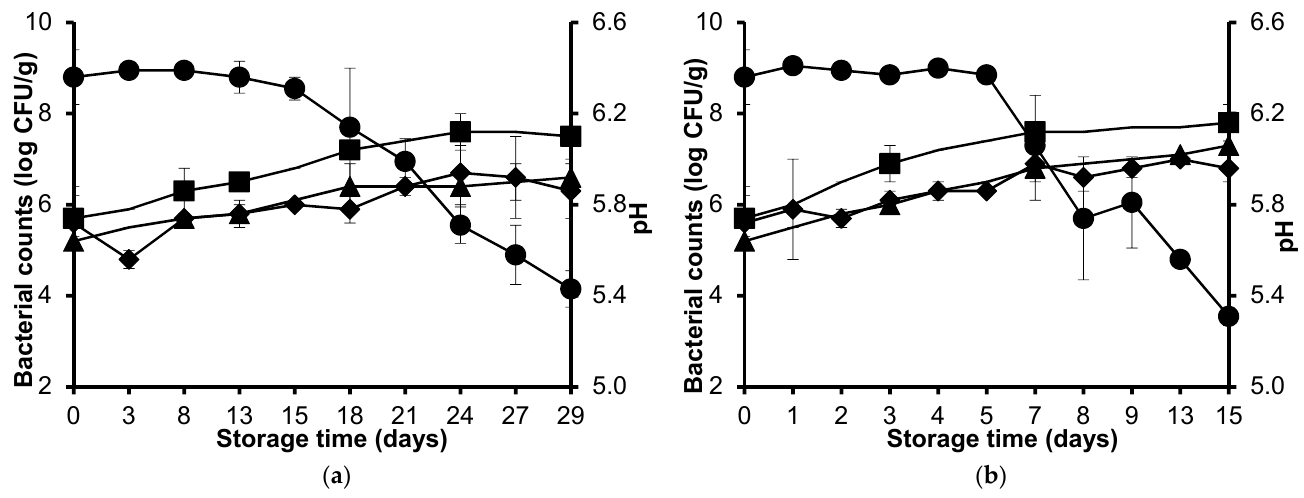
Figure 1. Bacterial counts of TVC ( (cid:4) ), LAB ( (cid:78) ), L. monocytogenes ( (cid:7) ), and changes in pH ( • ) during storage of an RTE cooked, cured meat product inoculated with a cocktail of L. monocytogenes serotypes. ( a ) Storage of the meat product at 4 ◦ C; ( b ) storage of the meat product at 10 ◦ C. Symbols and error bars represent the average value and standard deviation, respectively, of three replicates. Table 1. Recoveries for L. monocytogenes strains of different serotypes during the refrigerated at 4 ◦ C or temperature abused at 10 ◦ C storage of an artificially contaminated RTE pork meat product.